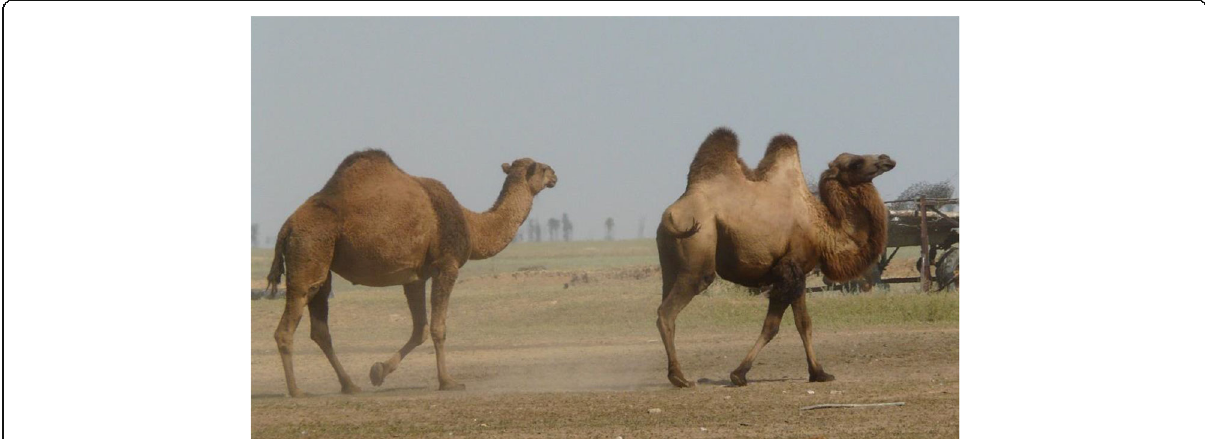
Fig. 21 Dromedary and Bactrian camels cohabiting in the same farm, Ouralsk, Kazakhstan (Ph. B.